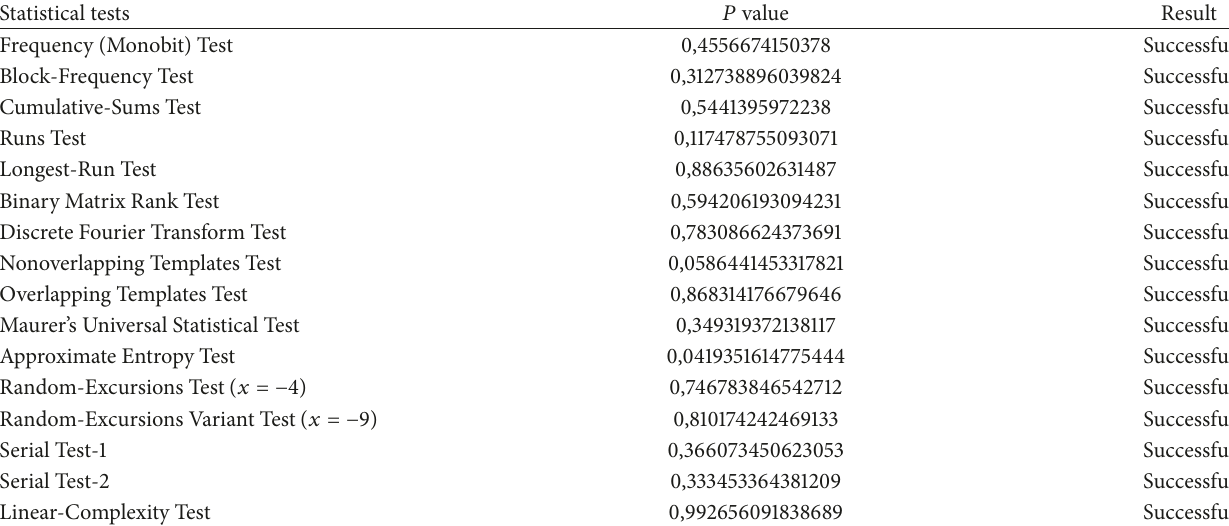
Table 1: NIST-800-22 test results of the new chaotic system based RNG.